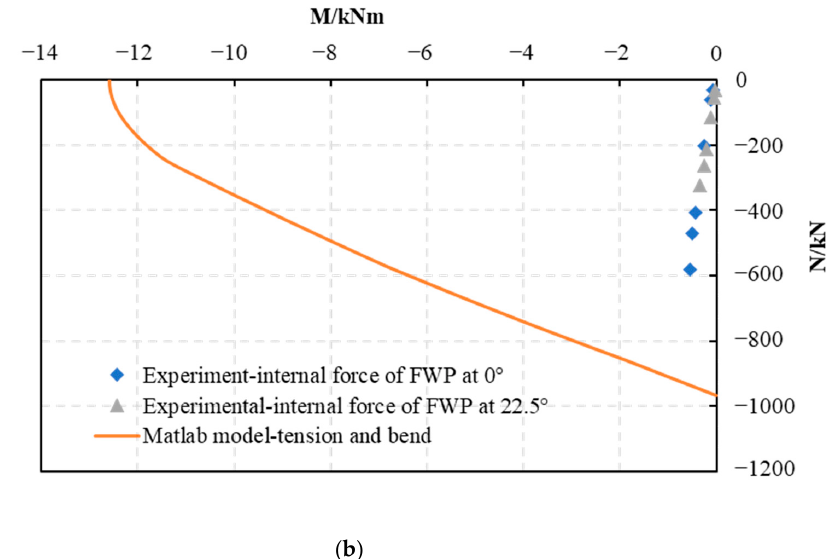
Figure 16. Comparison between the simplified calculation model solutions and the experimental results: ( a ) compression–bending conditions; ( b ) tension–bending conditions.